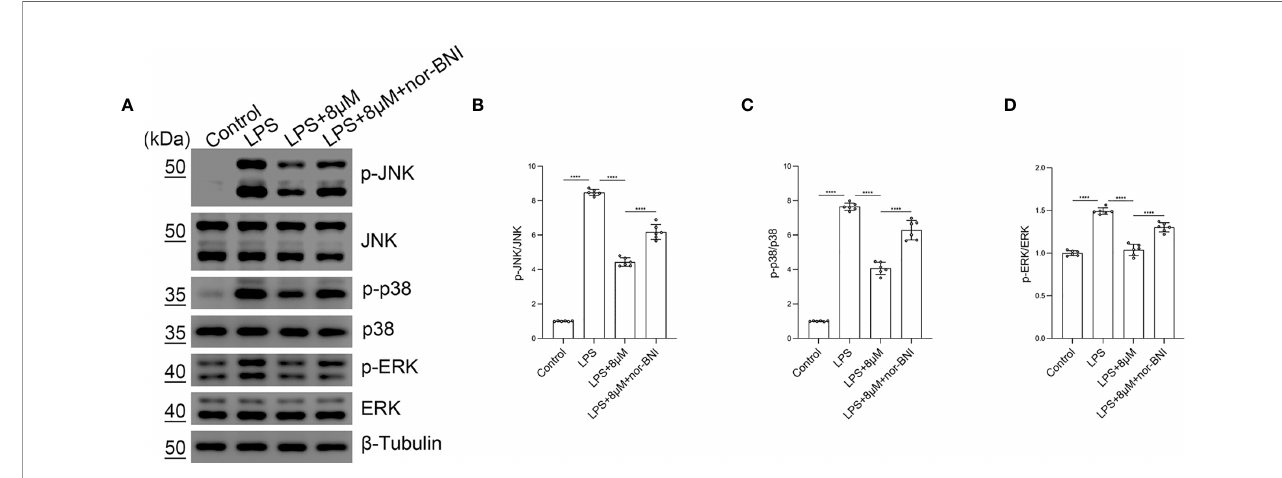
FIGURE 9 | Butorphanol prevented the phosphorylation of MAPKs through KOR in M1-polarized BMDMs. Macrophages were collected and cultured from the bone marrow of mice and incubated with LPS (1 m g·mL -1 ) alone, butorphanol (8 m M) plus LPS (1 m g·mL -1 ) or nor-BNI (KOR antagonist, 5 m M) plus butorphanol (8 m M) plus LPS (1 m g·mL -1 ) for 30 min. Cells were pretreated with nor-BNI for 30 min. (A) The levels of phosphorylated MAPKs and their respective total proteins were measured by western blot analysis. (B – D) Densitometric analysis of the phosphorylated MAPKs levels in (A) was performed with normalization to the respective total proteins. The results are the means ± SEM of six independent experiments. Statistical analysis was performed by one-way ANOVA followed by Tukey ’ s post hoc test when comparing multiple independent groups. ****P < 0.0001.